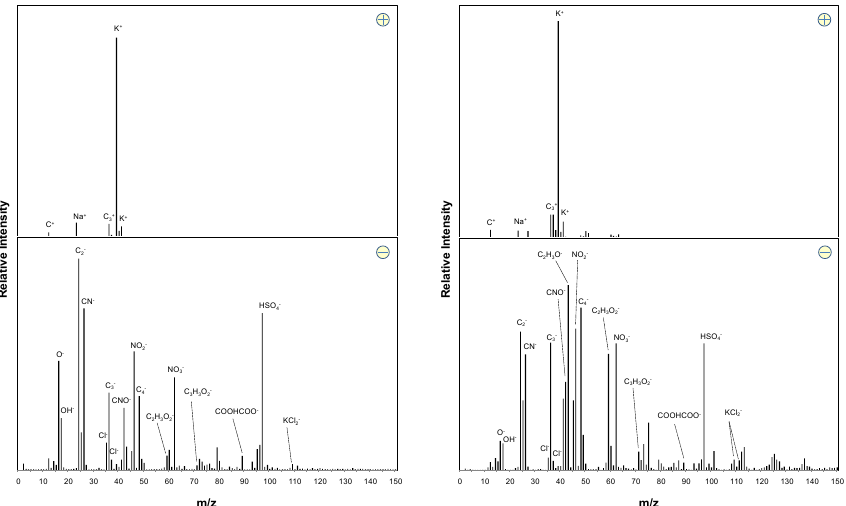
Fig. 5. Average dual ion mass spectra of ambient particles classified as “Wood” (left) and particles sampled during the wood combustion experiment (right).